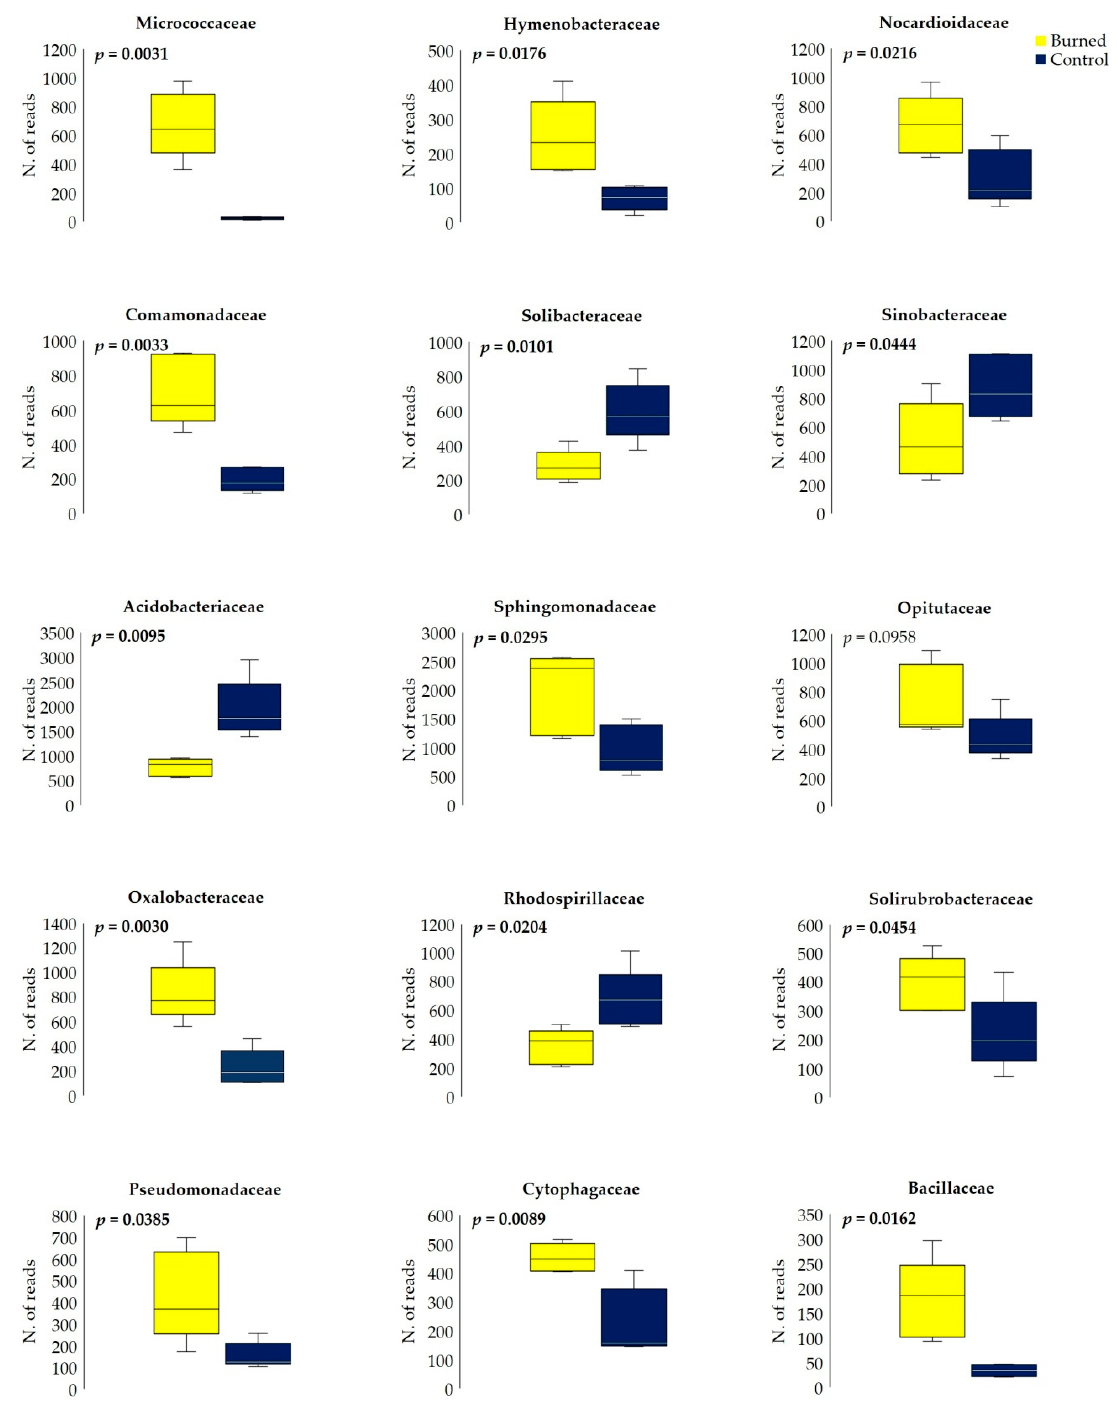
Figure 9. Variations in bacterial richness within main families, between burned and control (n. of row reads; rectangles define 25th and 75th percentiles, horizontal lines show median values, and t -test p < 0.05). Raw data and differential analysis results are available in Table S4.